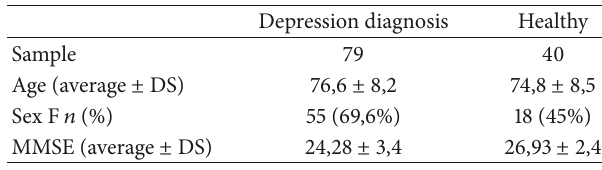
Table 1: Characteristics of the sample.